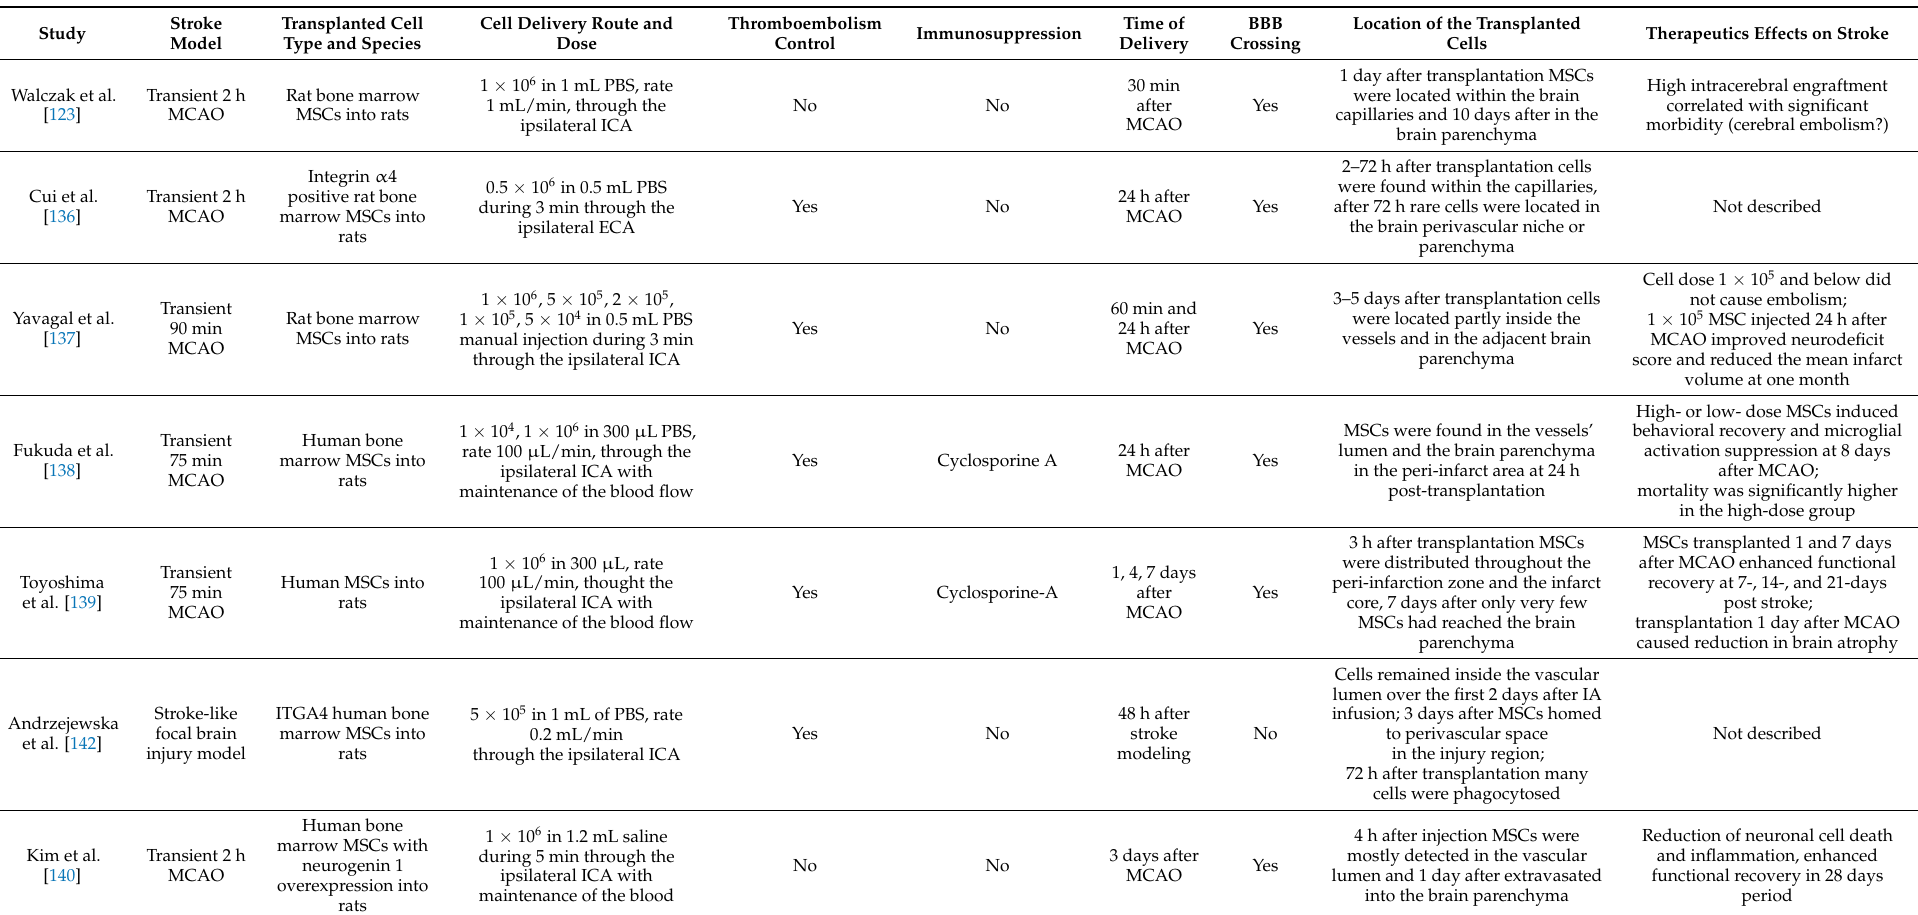
Table 1. Results of the studies of the penetration of MSCs through the BBB in experimental stroke models presented in selected papers. The main criterion for paper selection was quality imaging and clear description of the exact location and fate of MSCs after IA transplantation. Secondary criteria are described in the text. MCAO: middle cerebral artery occlusion. IA: intra-arterial. ICA: internal carotid artery. ECA: external carotid